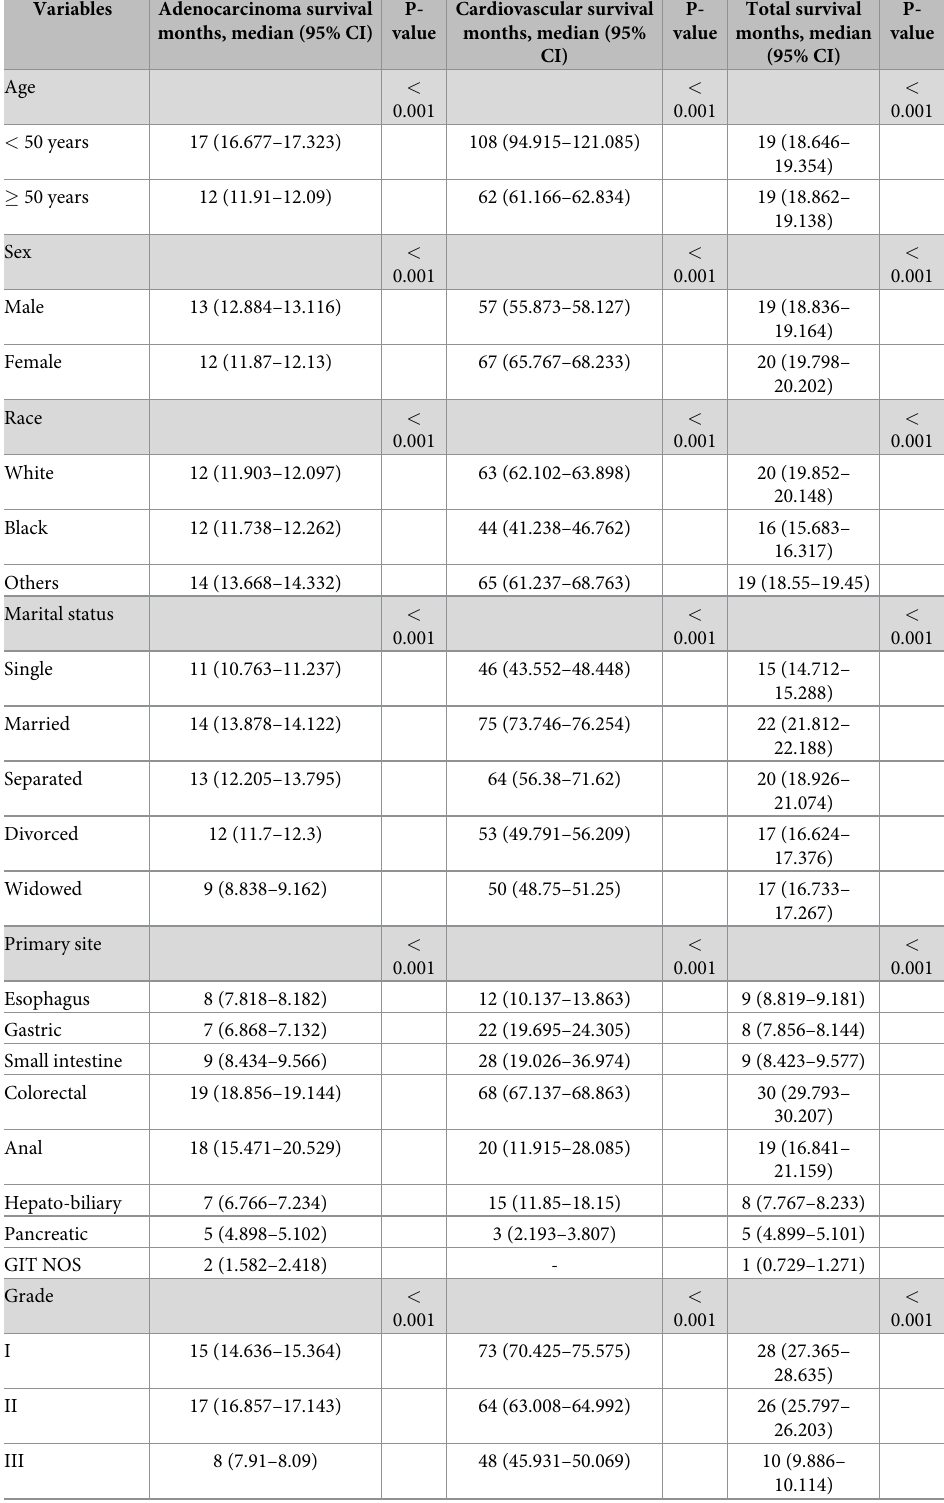
Table 2. Univariate analysis using Kaplan Meier